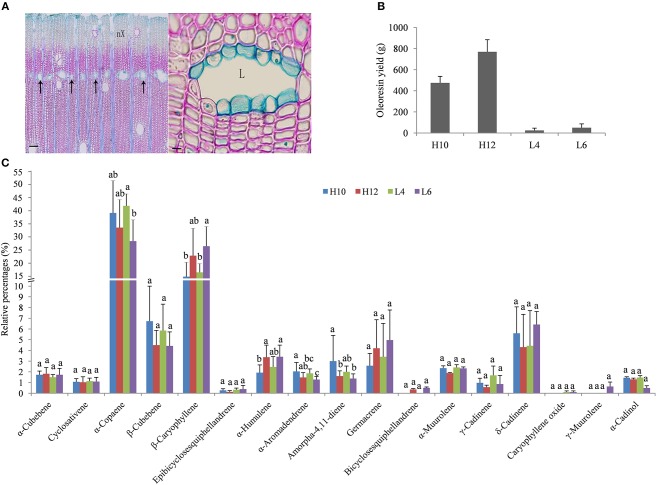
Structure of secretory canals and terpene profile in the S. glabra stem. (A) Anatomical structure of secretory canals. Left, secretory canals distributed along the marginal parenchyma bands (arrow); Right, secretory canals at the mature stage; nX, New xylem; L, Lumen; Scale bars: Left, 100 μm; Right, 10 μm. (B) Oleoresin yield in S. glabra plants. (C) Chemical composition of terpenes by GC-MS. Error bars indicate the standard error. The different lower case letters above the columns indicate significant differences based on ANOVA (p < 0.05).